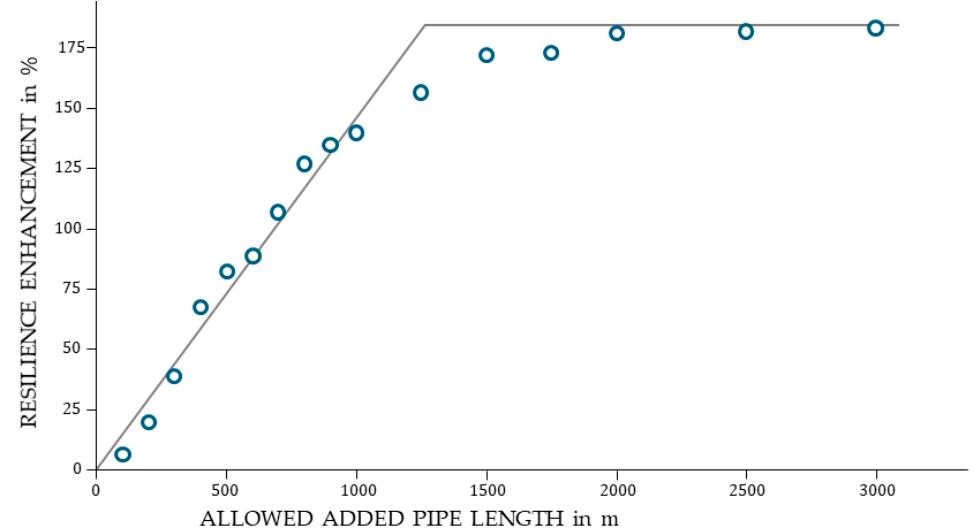
Figure 3. Cost-benefit resilience analysis given as the Pareto front of the existing WDS embedded in its urban